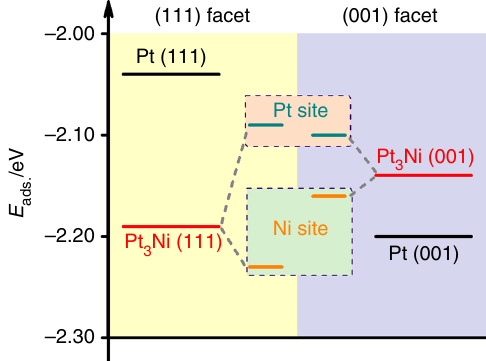
Fig. 4 CO adsorption energy on different facets. DFT calculation of CO adsorption energy on the (111) and (001) facets of surface Ni-enriched Pt 3